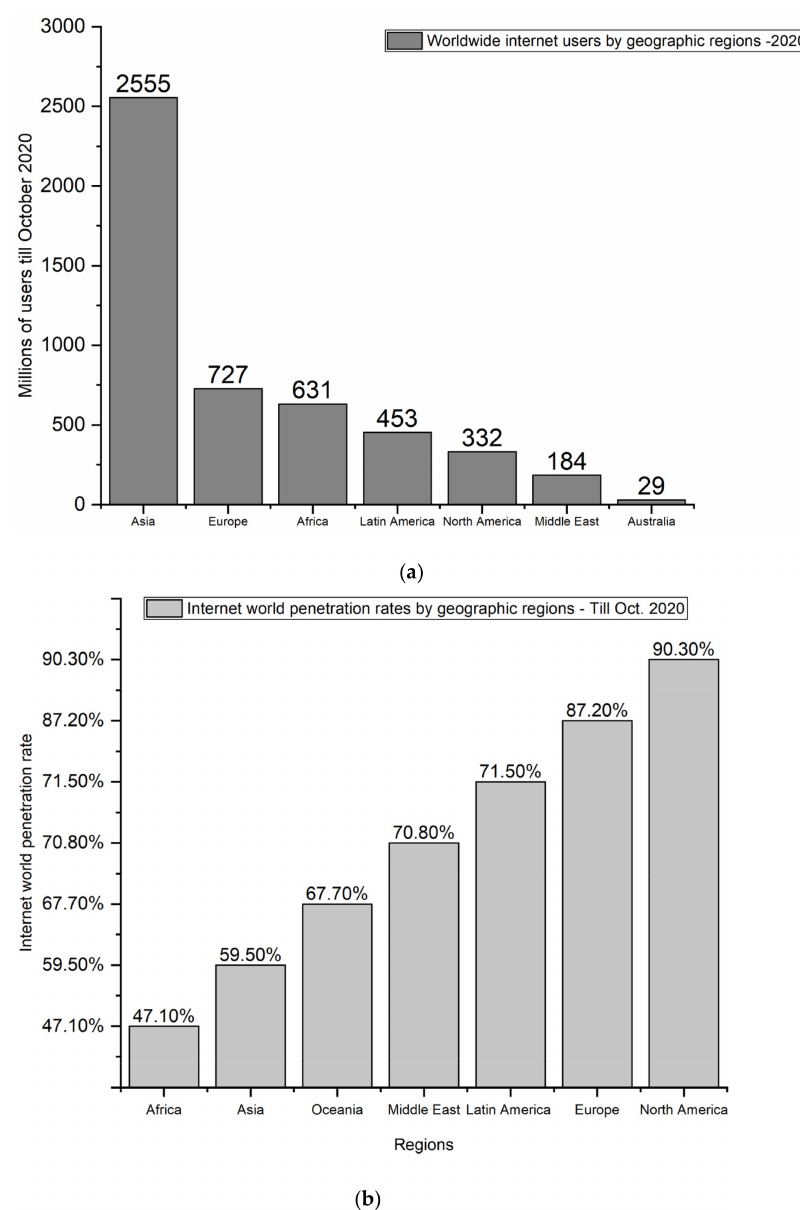
Figure 4. ( a ) Internet users worldwide. ( b ) Internet world penetration rate